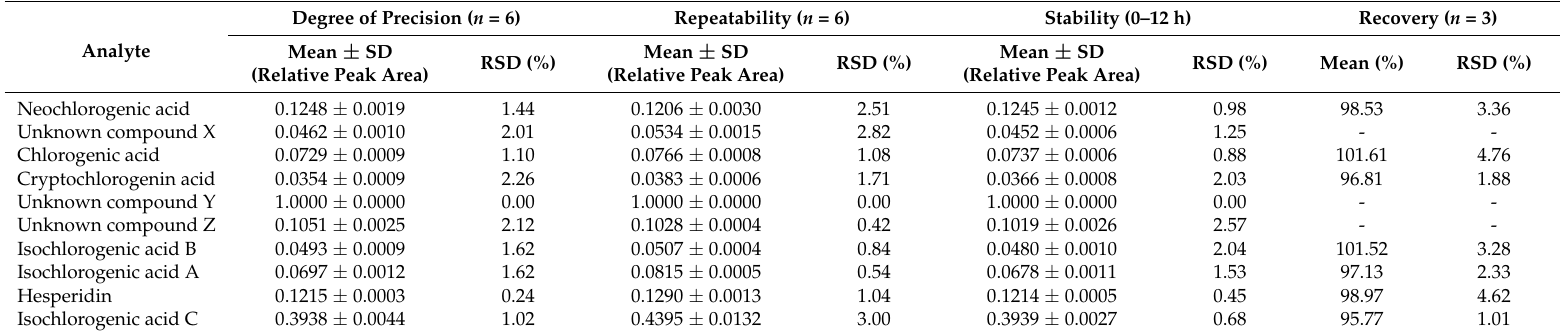
Table 1. Repeatabilities, stabilities and recoveries of the 10 compounds in ZZX.